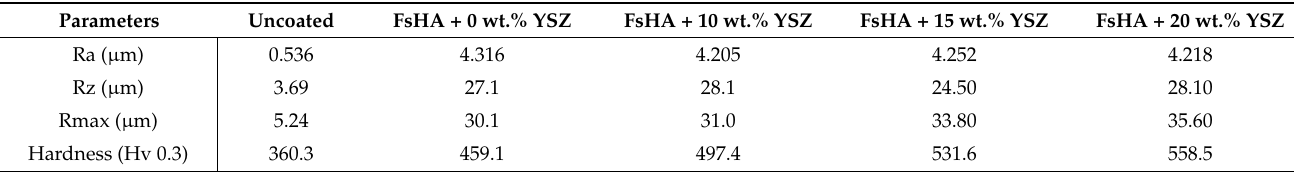
Table 3. Surface roughness and hardness of FsHA/YSZ